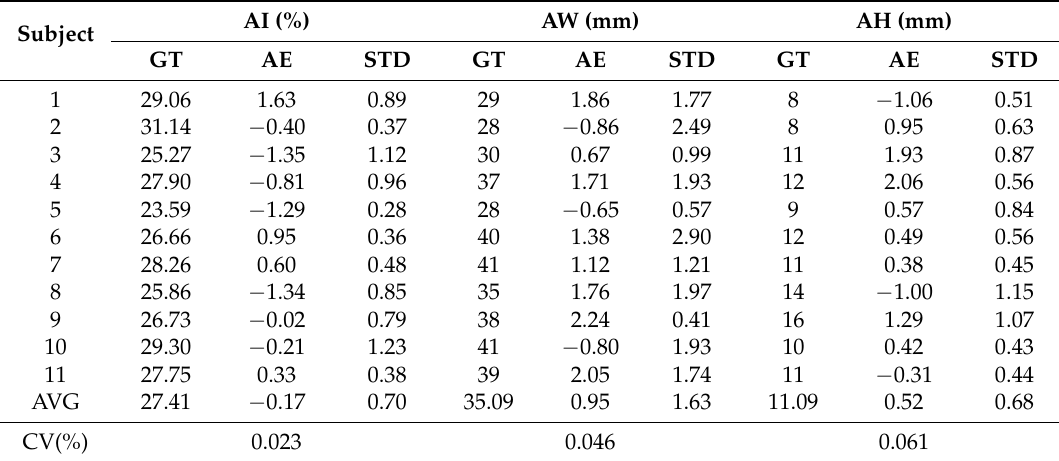
Table 1. Accuracy and repeatability assessment.